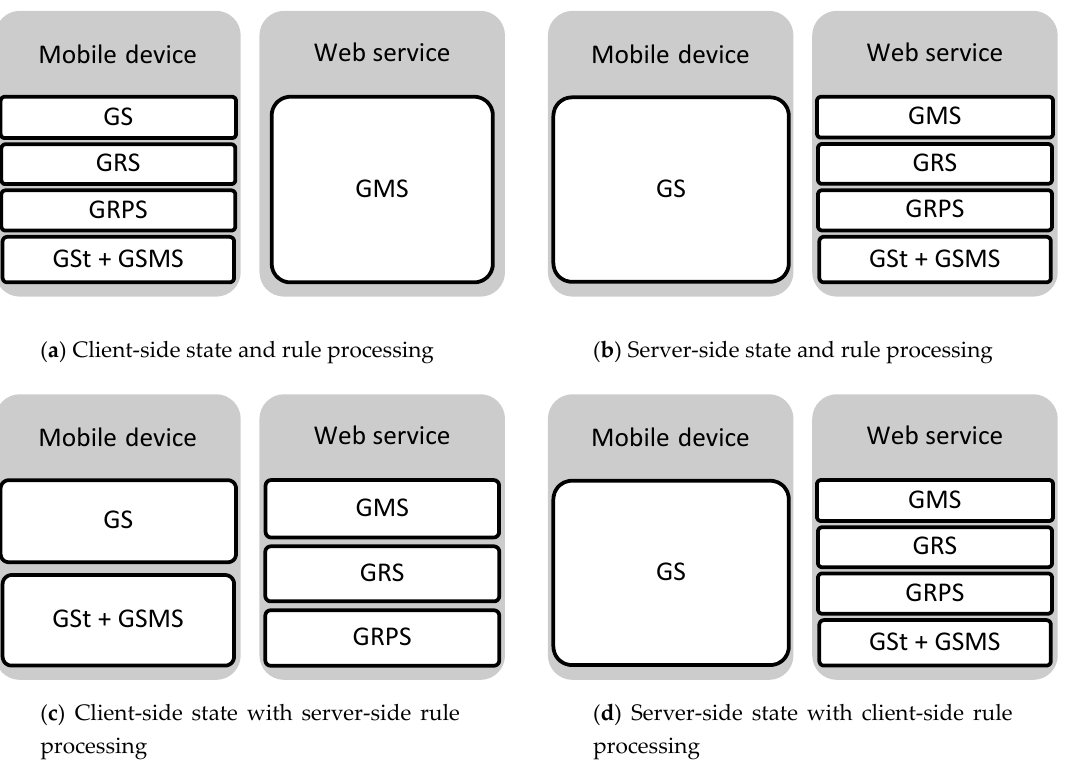
Figure 2. Primary e-guide gamification system organizations.